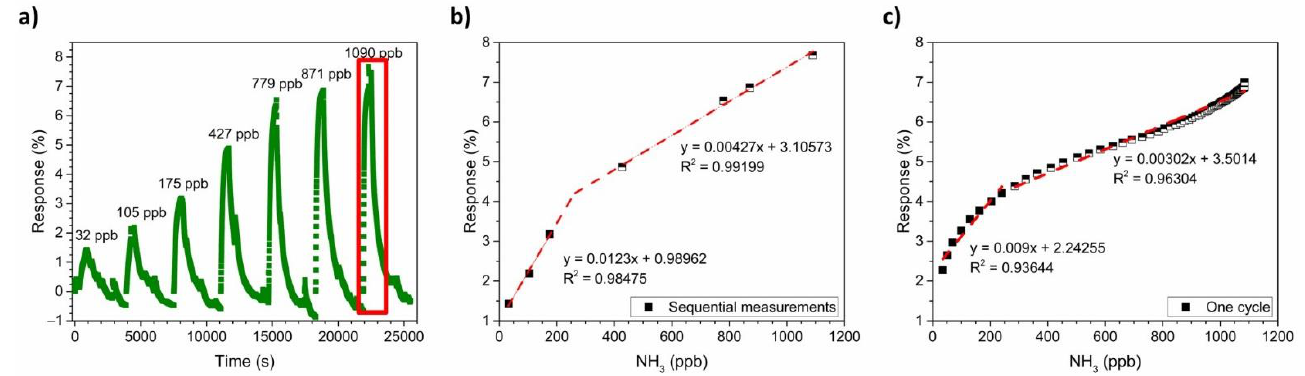
Figure 11. NH 3 calibration: ( a ) PANI-Au-SPE sensor’s response after exposing to different concentrations of gas; ( b ) cali- bration curve obtained from the PANI-Au-SPE sensor’s response at maximum achieved gas concentration in sequential measurements and ( c ) calibration curve obtained from one cycle of measurements.